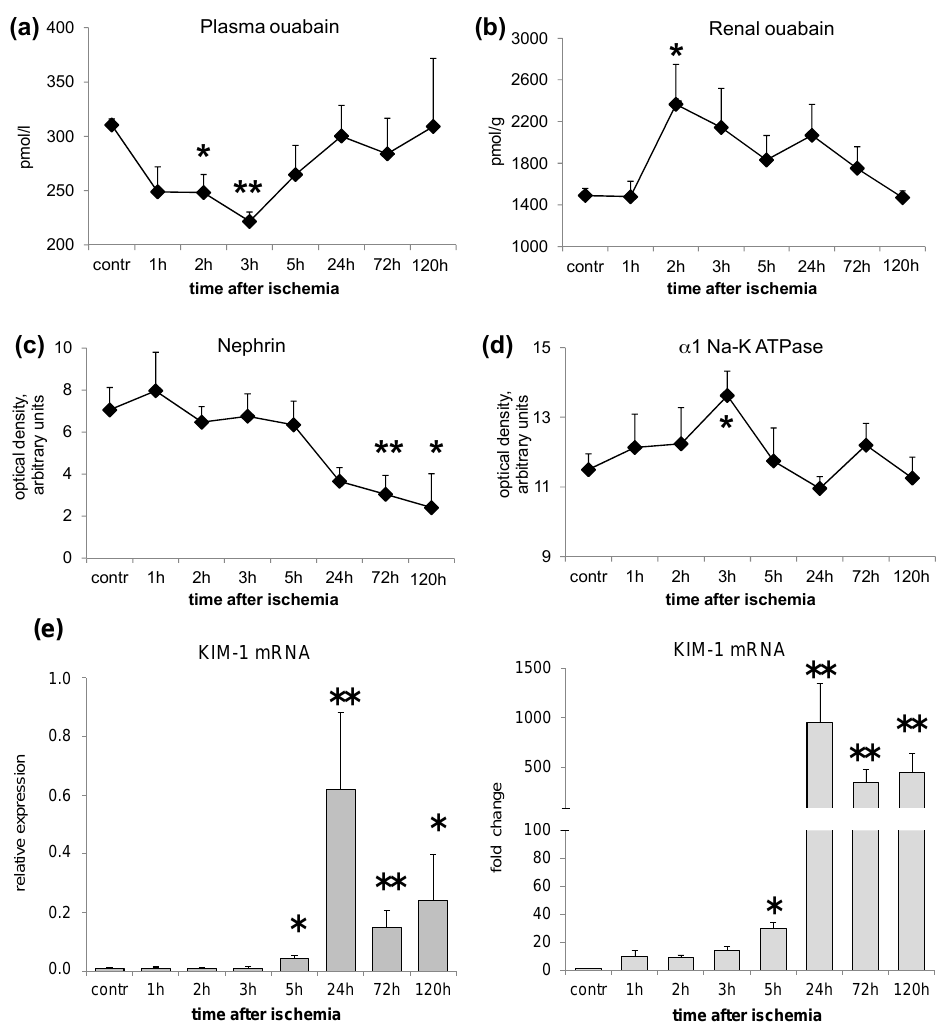
Figure 1. Time course of EO and protein marker changes after IRI (ischemia-reperfusion injury). Rats underwent right nephrectomy and ischemia was performed by clamping the left artery for 45 min. Reperfusion was followed after 1 to 120 h from the beginning of ischemia. At each time (1, 2, 3, 5, 24, 72, 120 h), rats ( n = 3/8 per group, see Methods) were sacrificed and plasma and kidney were removed to measure endogenous ouabain (EO) levels and protein biomarkers. ( a , b ) Time course of EO changes in plasma of ischemic rats versus controls and in ischemic versus contra-lateral healthy kidney measured by radioimmunoassay (RIA); ( c , d ) Effect of ischemia-reperfusion on nephrin and α 1 Na-K ATPase protein expression in the ischemic versus contra-lateral healthy kidney quantified by immunoblotting. Optical densities are expressed as arbitrary units; ( e ) Kidney-Injury-Molecule-1 (KIM-1) mRNA as relative expression in the ischemic kidney ( left ) and as fold change ( right ) versus contra-lateral healthy kidney determined by RT-PCR. Data are mean ± SEM, * p < 0.05; ** p < 0.01 vs. control.